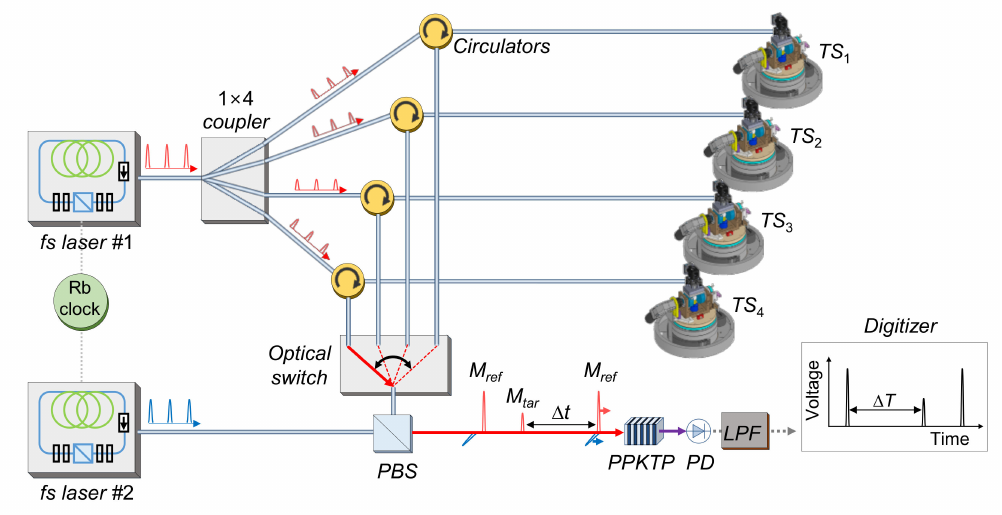
Figure 7. Configuration of absolute distance measurement for the MLTS (fs: